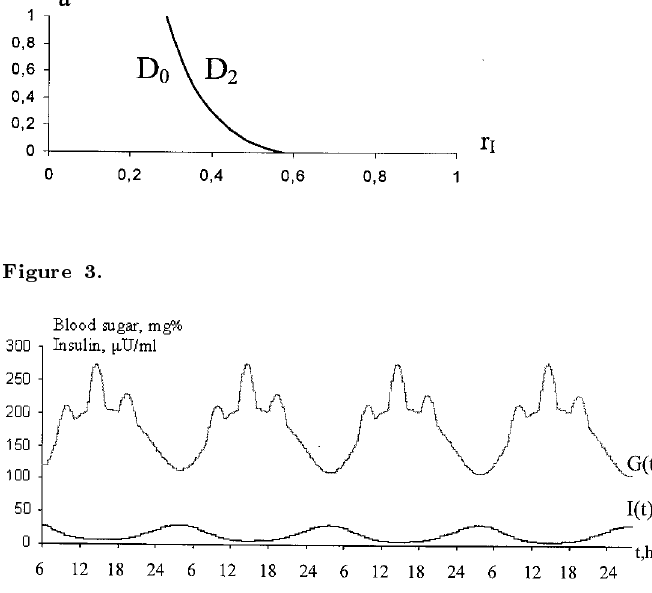
Figure(cid:4)(cid:1)Onlymealswithoutintroductionofinsulin(cid:8)Breakfast(cid:2)(cid:1)(cid:8)(cid:10)(cid:10)a(cid:8)m(cid:8)(cid:9)